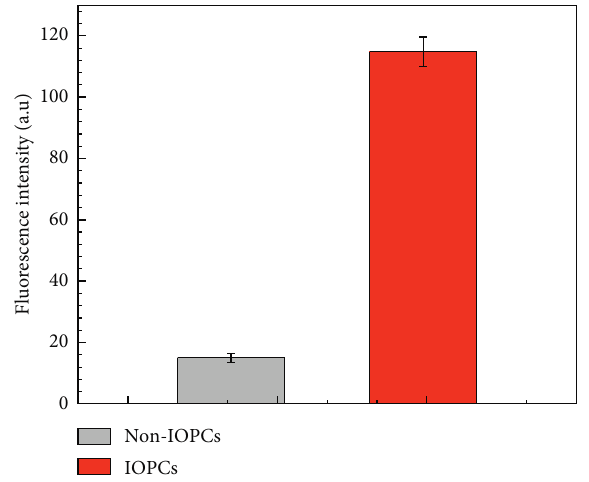
Figure 6: Fluorescence intensities of PEGDA/SiO and the IOPCs for Fluor ® 488